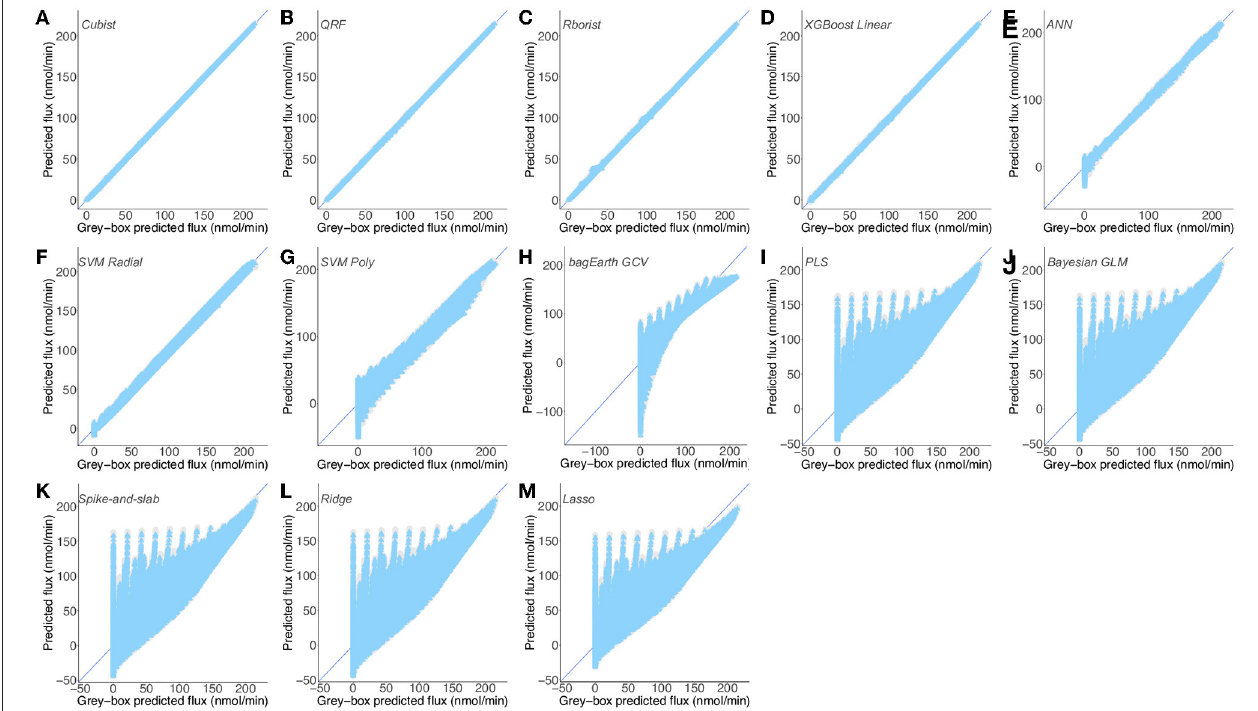
FIGURE 5 | Predictions of a mix of experimental and gray-box predicted flux by different predictive models. (A–D) Flux from Dataset 1 ( Supplementary Table 7 ) predicted by the Cubist (A) , QRF (B) , Rborist (C) , XGBoost Linear (D) , ANN (E) , SVM Radial (F) , SVM Poly (G) , bagEarth GCV (H) , PLS (I) , Bayesian GLM (J) , Spike-and-slab (K) , Ridge (L) and Lasso (M) models. Gray circles: training set and blue triangles: test set. See Table 3 for the statistical measurements of each model.